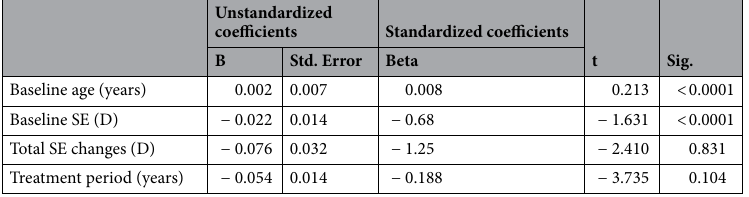
Table 2. Factors influencing the 0.01% atropine treatment results. The data were obtained via logistic regression. D diopter, SE spherical equivalent, SD standard